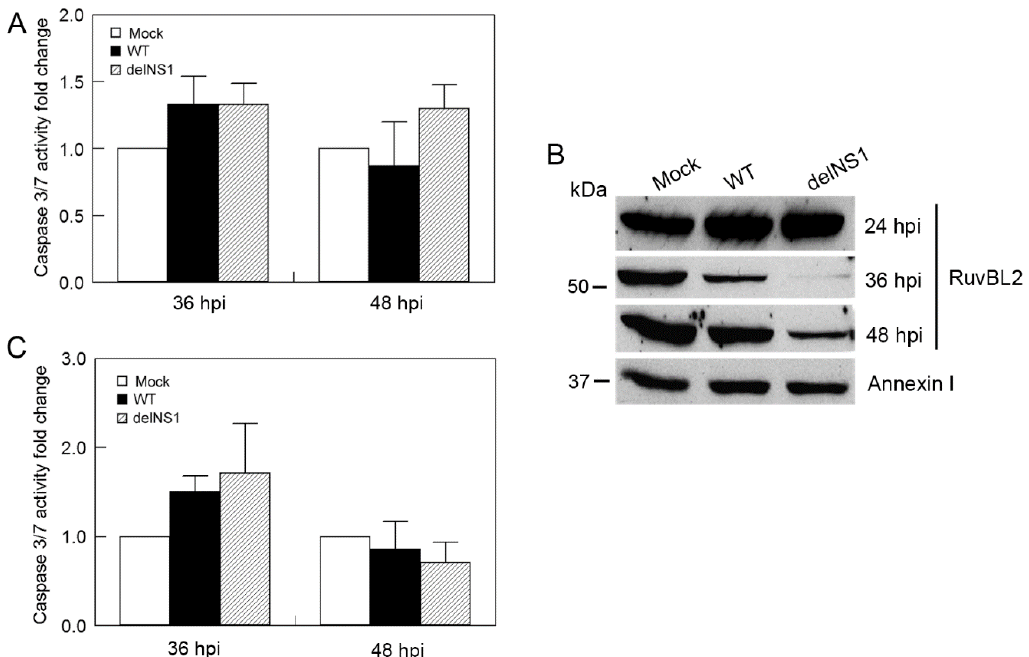
Figure 8. IFNs inhibit IAV-induced apoptosis in infected cells. ( A ) IAV infection does not induce apoptosis in A549 cells. A549 cells were mock-infected or infected with WT or delNS1 PR8 virus at an MOI of 1 for 36 and 48 h, and then harvested for determinations of caspase 3/7 activities. ( B , C ) IAV infection suppresses RuvBL2 cellular protein abundance but does not affect apoptosis in the Vero cells pretreated with a recombinant IFN. Vero cells were pretreated with a recombinant universal human IFN-α at 1000 U mL −1 for 6 h, and then mock-infected or infected with WT or delNS1 virus at an MOI of 1. The cells were harvested at the indicated time points either for Western blotting analysis ( B ) or caspase 3/7 activity measurement ( C ). Values in ( A , C ) are the means ± SE of three separate sample preparations.